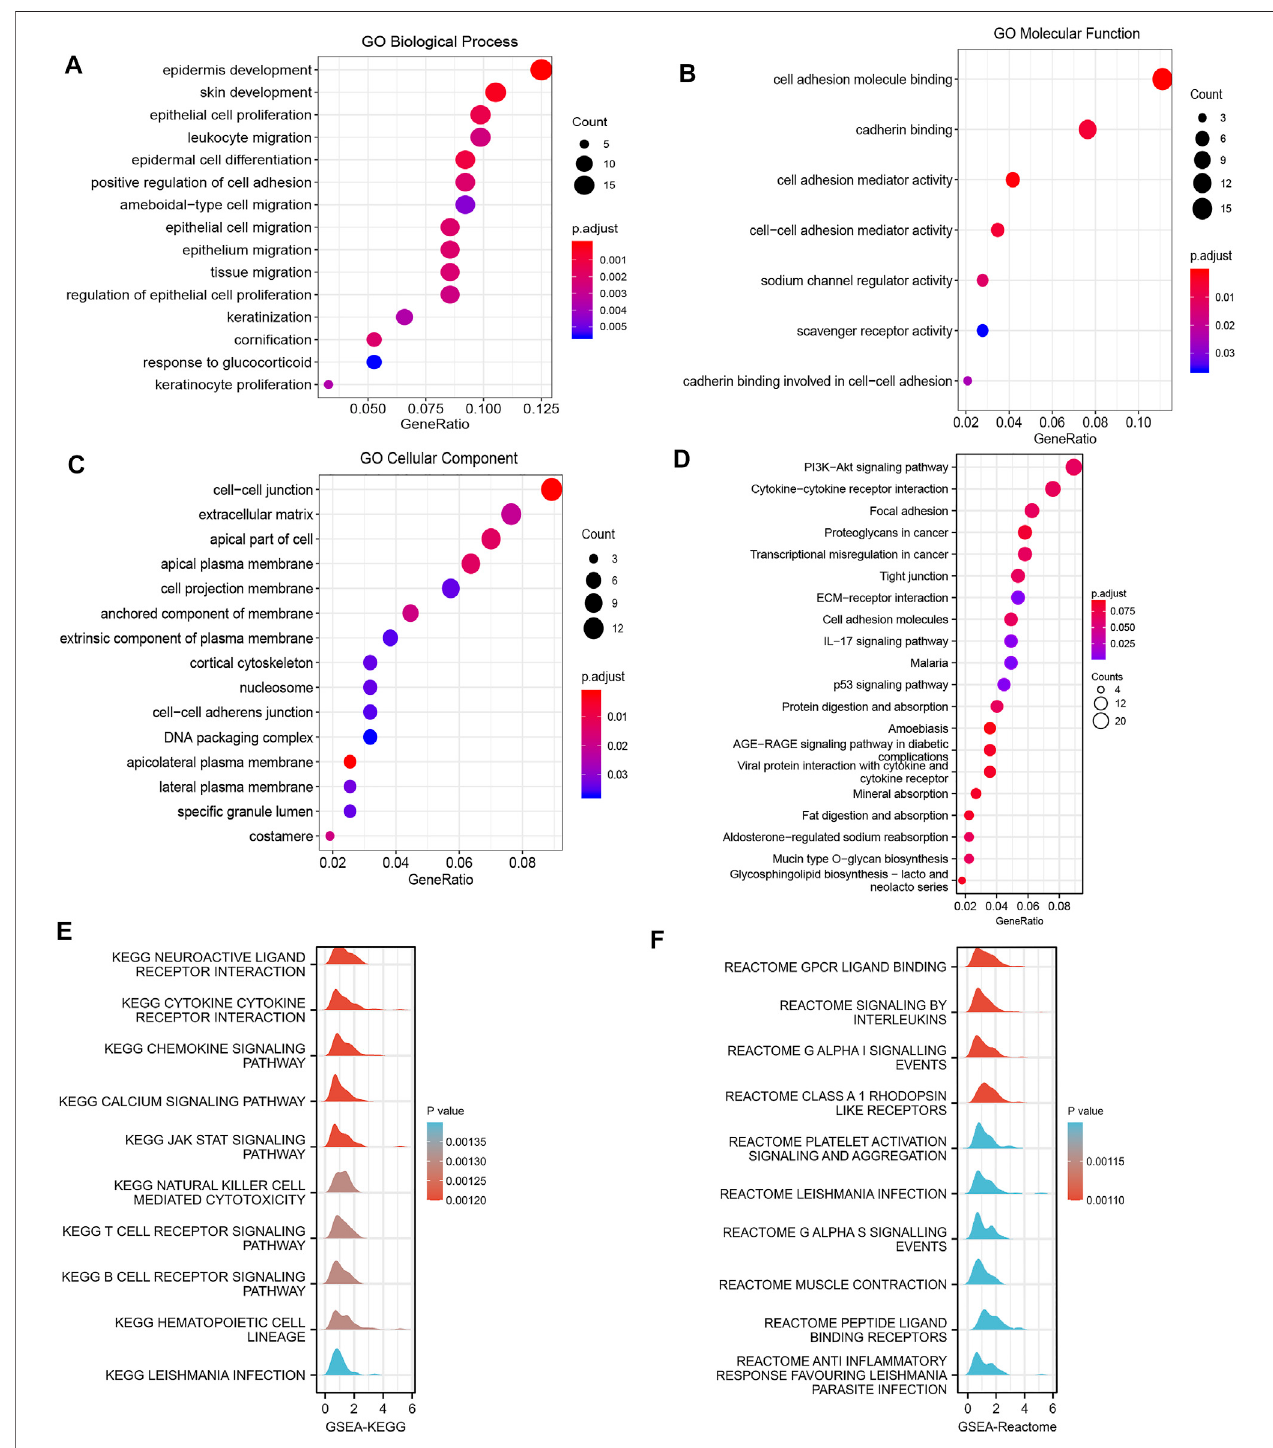
FIGURE 6 | Function and pathway enrichment analyses of TMEM170B in pancreatic adenocarcinoma. (A – C) Signi fi cant GO terms of the top 300 genes most positively associated with TMEM170B, including biological processes, molecular function, and cell component. (D) Signi fi cant KEGG pathways of TMEM170B-related genes. (E,F) Signi fi cant GSEA results of the top 300 genes most positively associated with TMEM170B, including KEGG pathways and Reactome pathways.